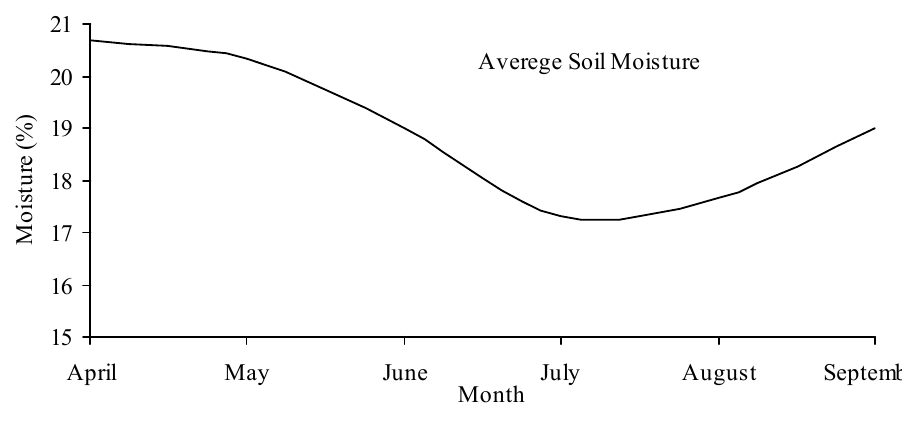
Figure 10. Monthly average moisture.